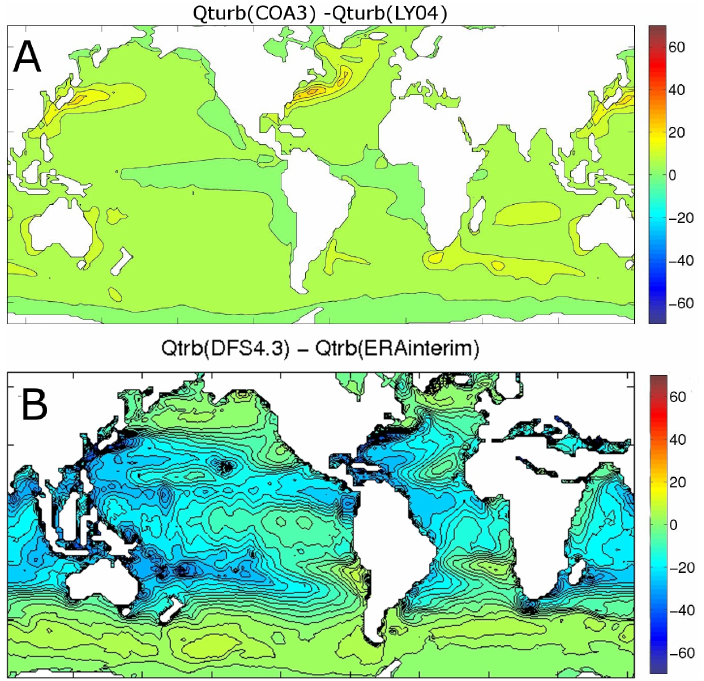
Fig. 1. Top: Mean difference between turbulent heat flux ( Q turb = Q lat + Q sens , in Wm − 2 ) climatologies (1984–2000) estimated from different bulk algorithms (different transfer coefficients parametrizations): COA3 described by Fairall et al. (2003) and LY04. These clima- tologies are computed with the same atmospheric forcing field and the same prescribed SST (from Brodeau (2007)). Bottom: Mean difference between net heat-flux (in Wm − 2 ) climatologies (1989–2007) estimated with air temperature, air humidity and wind speed from different data sets (ERAinterim and DFS4.3 as described in Brodeau et al., 2010). These climatologies only differ by the atmospheric parameters used and are computed with the LY04 bulk